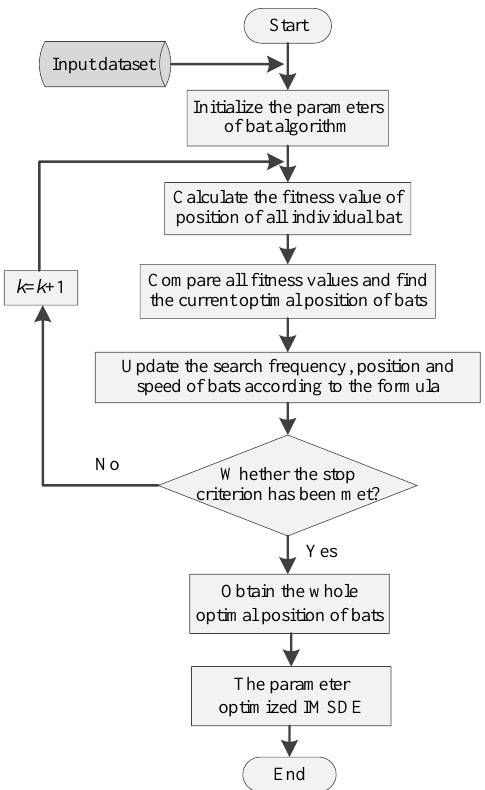
Figure 3. Flowchart of bat algorithm (BA)-based optimized improved multiscale symbolic dynamic entropy (IMSDE).